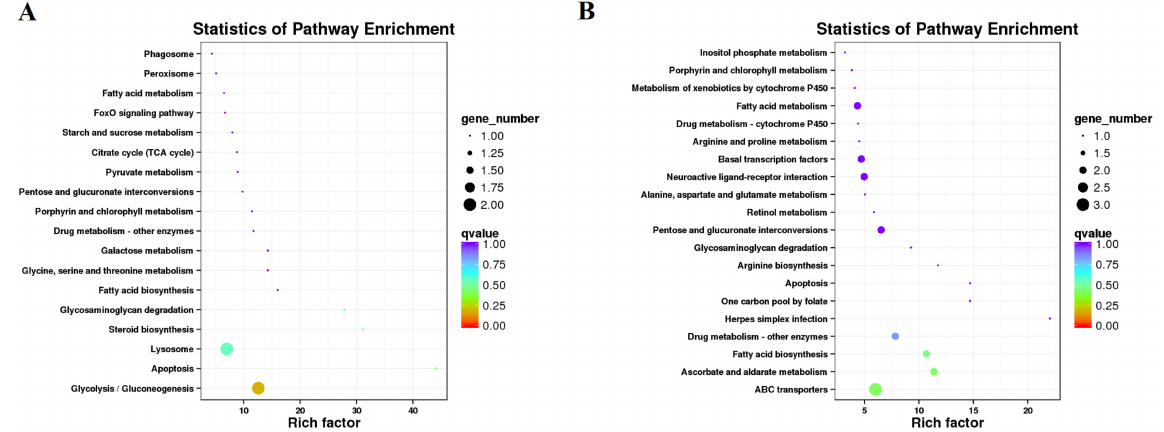
Figure 4. Enriched KEGG pathways for differentially expressed genes after JHA application. ( A ) One day after JHA application. ( B ) Two days after JHA